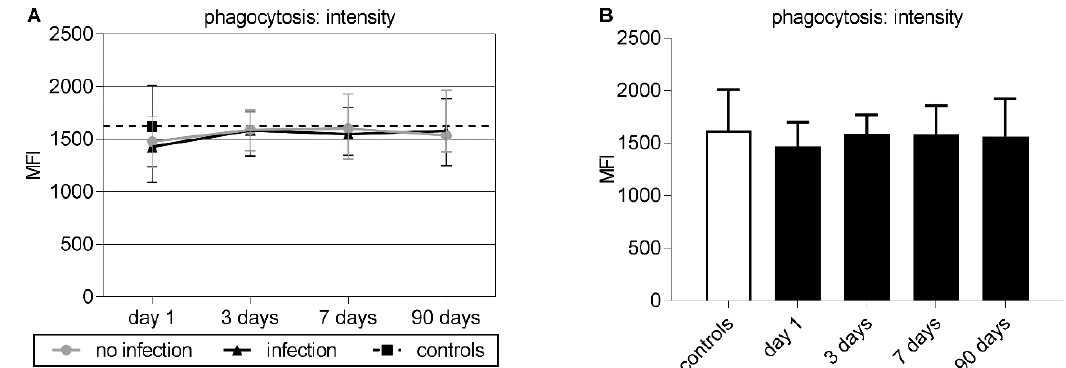
Figure 3. ( A – B ) Group medians and interquartile ranges of the phagocytosis intensity according to the incorporated amount of E. coli per neutrophil represented by the mean fluorescence intensity (MFI). ( A ) Time course of phagocytosis intensity for patients without infection (dot), patients with infection (triangle), and controls (black square). For better comparison, the control level is plotted as a dotted line over the entire time course. There were no significant results in day-by-day group comparison by Mann–Whitney U testing. ( B ) Time course for the phagocytosis intensity of neutrophils for all stroke patients (black bars) and control levels (white bars). There were no significant results between phagocytosis intensity of all stroke patients and control levels.